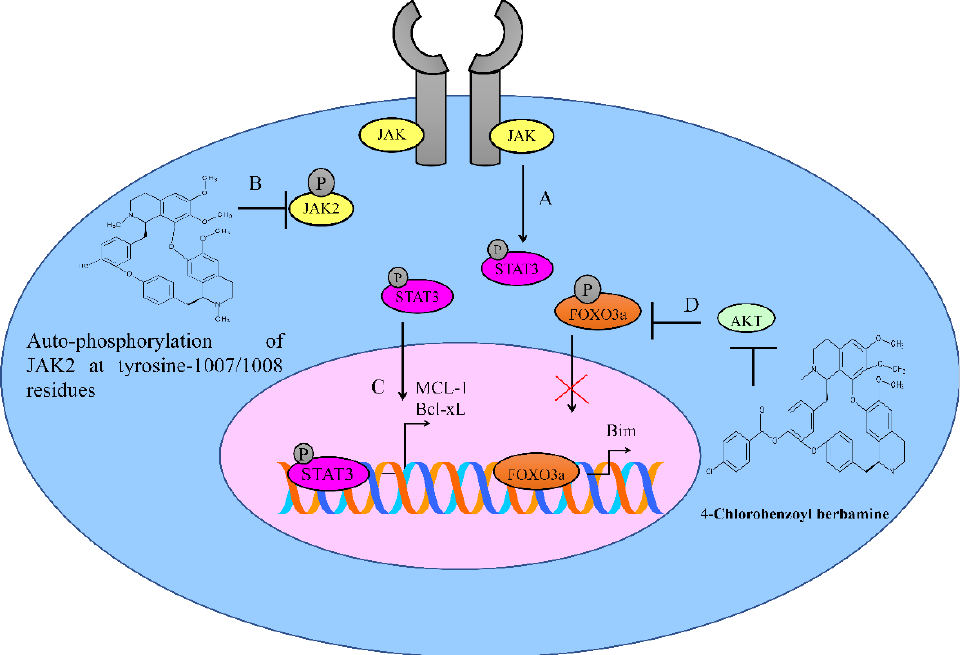
Figure 1. ( A–B ) JAK/STAT phosphorylation is involved in the regulation of different gene networks. Berbamine inhibits JAK2 auto-phosphorylation. ( C ) STAT3 transcriptionally upregulates MCL-1 and Bcl-xL. However, the inactivation of STAT3 leads to the repression of the STAT3-mediated expression of MCL-1 and Bcl-xL. ( D ) AKT inactivates FOXO3a and blocks the expression of pro-apoptotic Bim. Berbamine derivatives mediate inactivation of AKT, leading to an increase in FOXO3a-dependent upregulation of Bim.